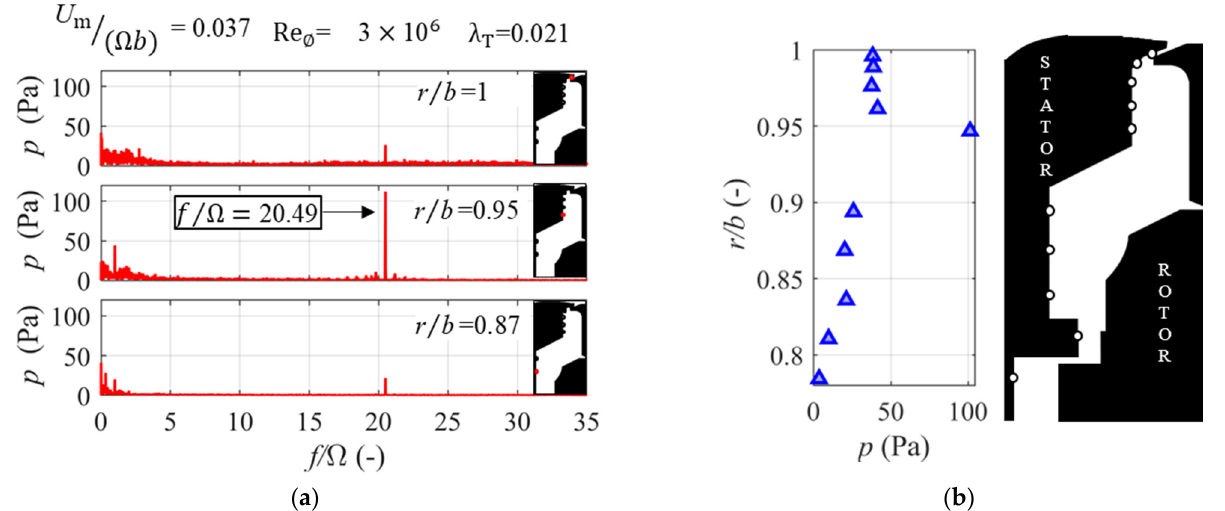
Figure 4. ( a ) Frequency spectra of the pressure signal FFT at three radial positions and ( b ) peak amplitude of the pressure FFT across the stator cavity wall.